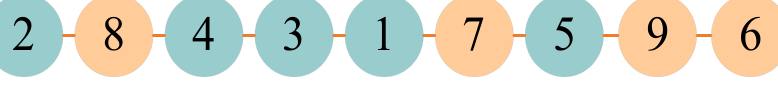
Fig. 5. An example of a state